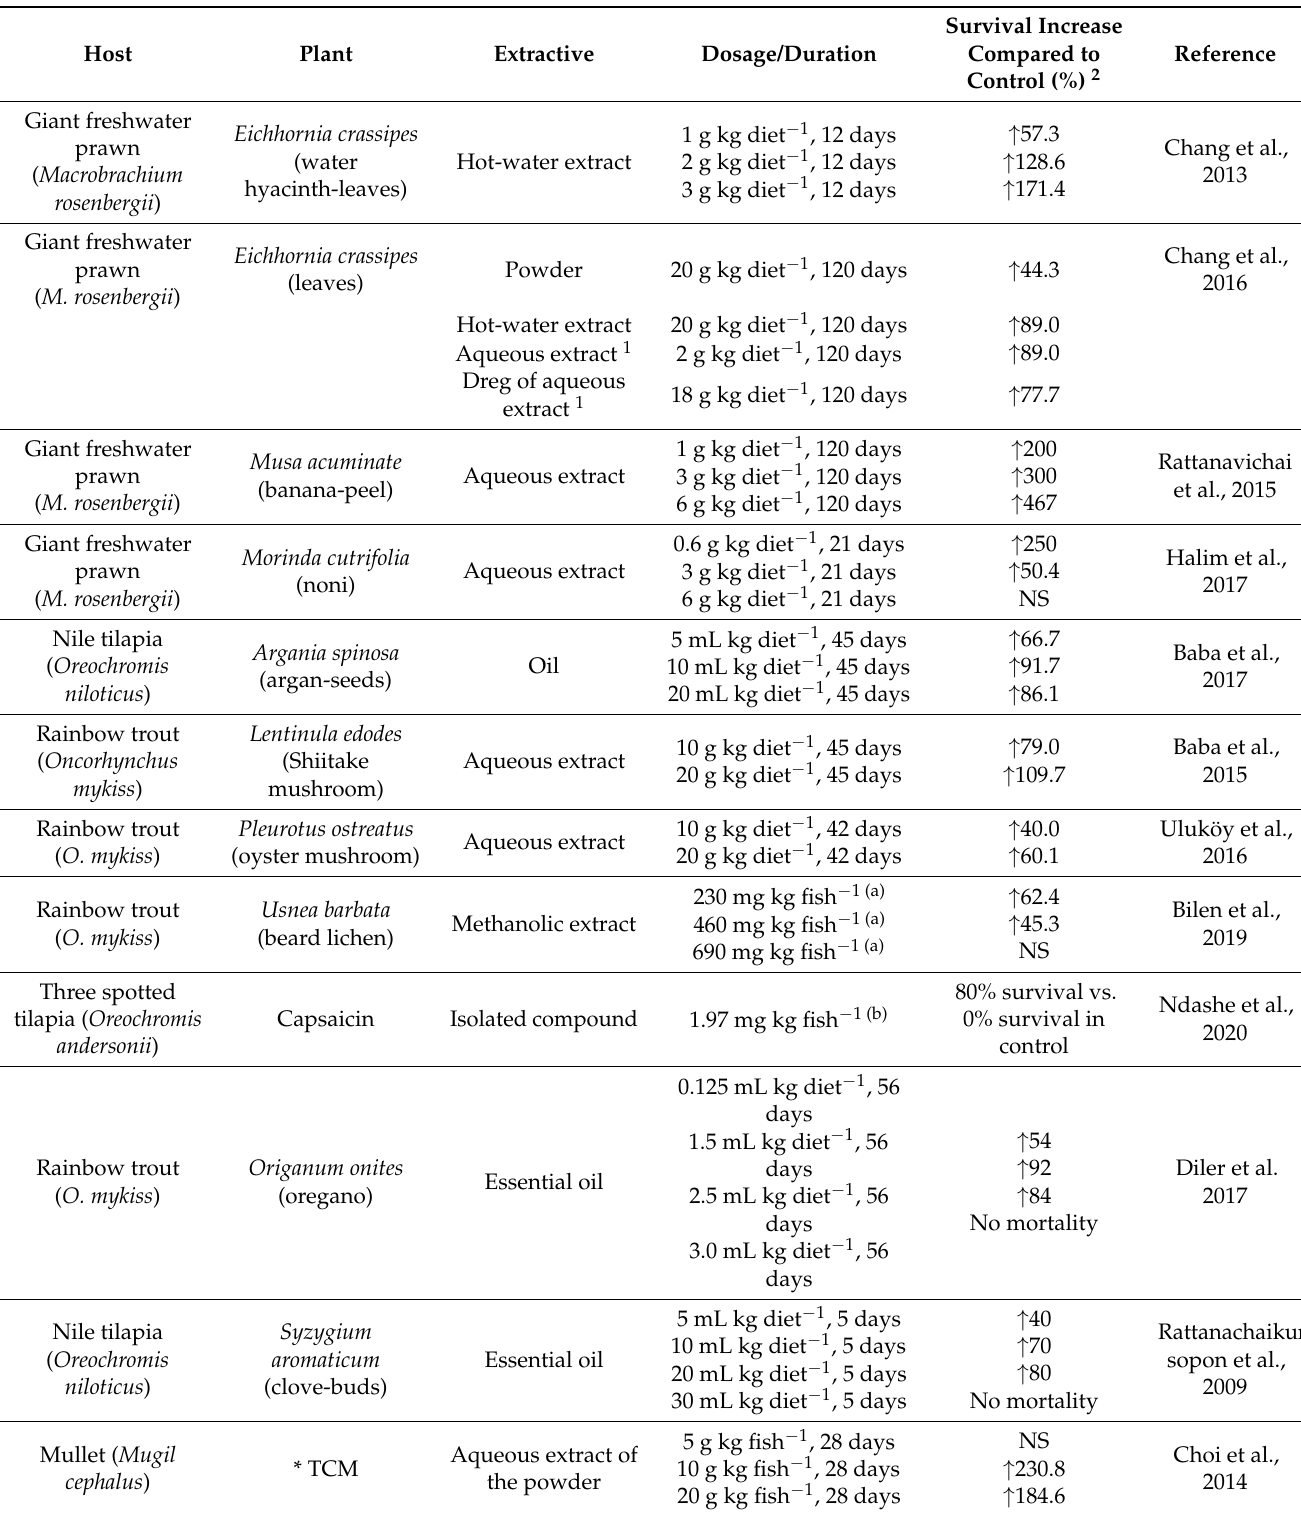
Table 2. Efficacy of medicinal herbs and plants on the survival of aquatic animals infected with Lactococcus garvieae . The portion of the plant used to prepare the extractives were cited only if stated in the